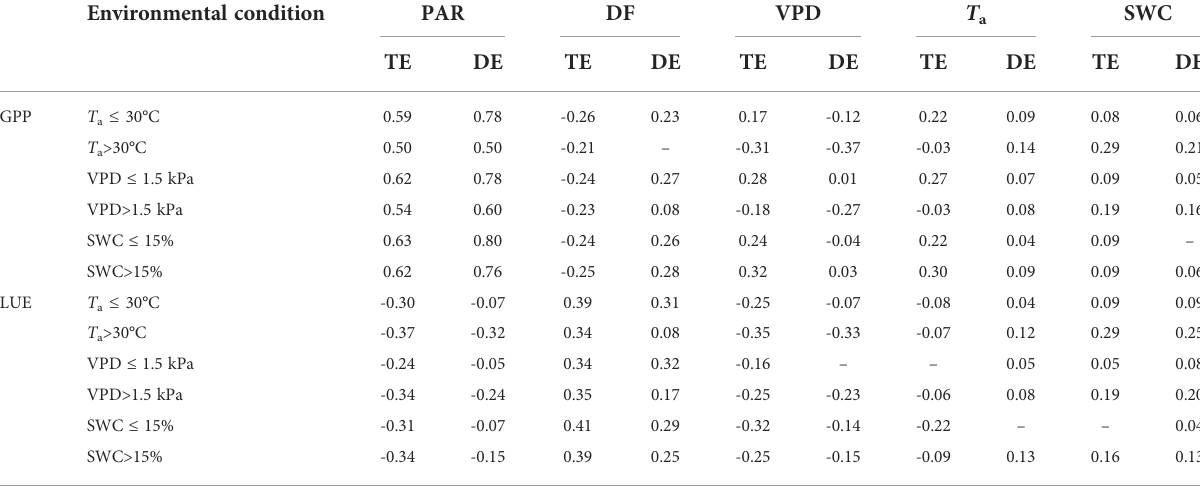
TABLE 3 Total effect (TE) and direct effect (DE) of environmental factors on gross primary productivity (GPP) and light use ef fi ciency (LUE). Environmental